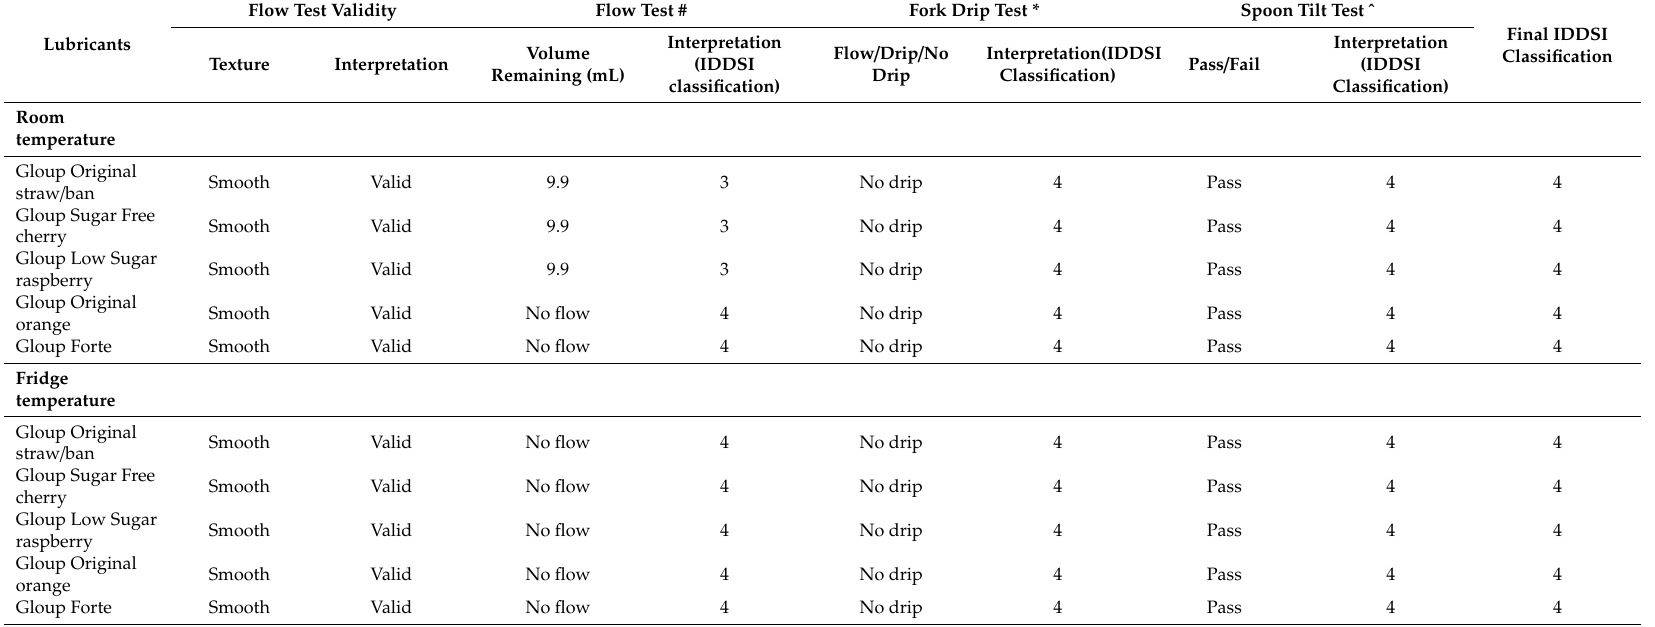
Table 4. Classification of Gloup products according to IDDSI testing methods when poured from the bottle, measured at room (24 ◦ C) or fridge temperature (4 ◦ C). Flow test validity (for fluids at all levels): smooth fluids are valid to be tested using the Flow test, while fluids that contain gristle, bone, husks, shell, fibres or lumps are not valid to be tested. Flow test (for fluids at all levels): the volume of fluid remaining in the syringe after 10 s. Fork Drip test (for fluids at level 3 and 4 in the Flow test): fluid drip and flow manner through fork prongs. Spoon Tilt test (for fluids at level 4 in the Fork Drip test): ability of fluid to hold its shape on the spoon and slide o ff easily when spoon is